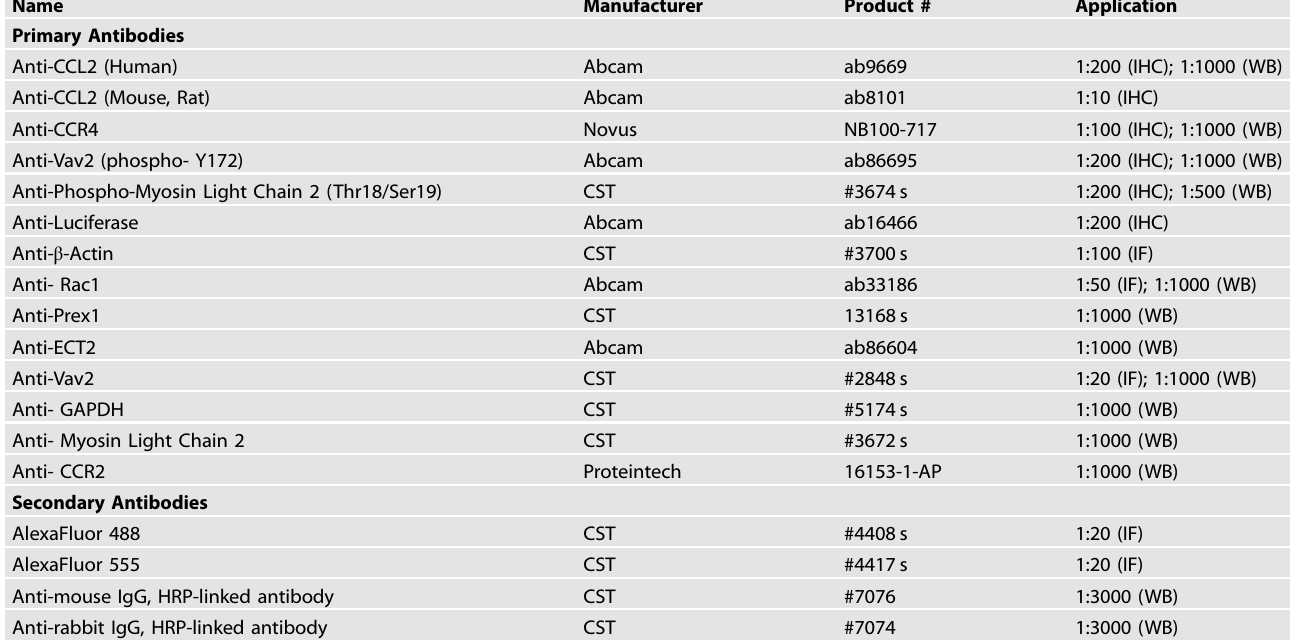
Table 1. The list of antibodies used in this experiment.